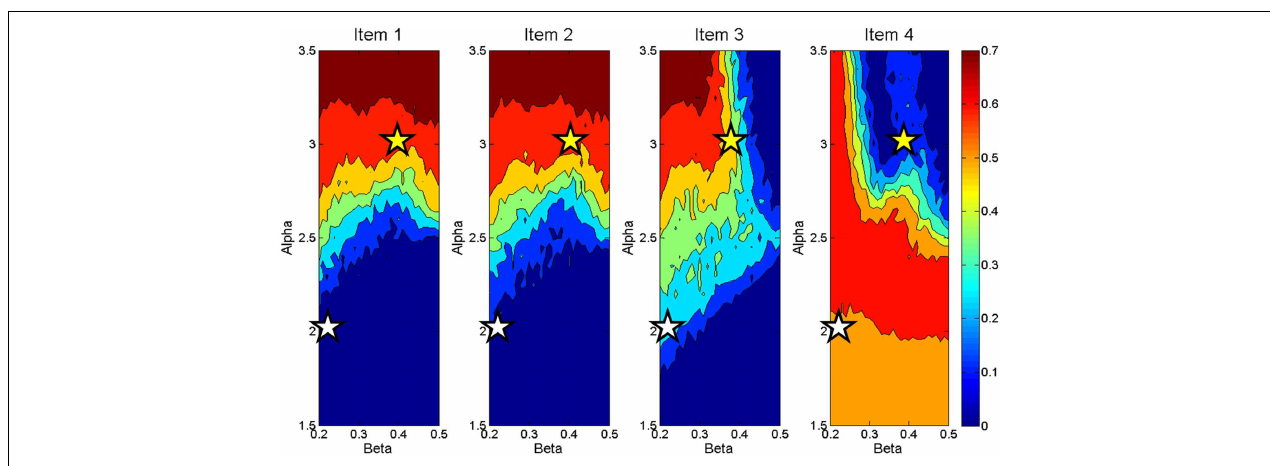
FIGURE 3 | Contour plot displaying activation values of four items at end of data presentation across a range of Beta ( X axes) andAlpha ( Y axes) demonstrating differences in activation weight gradients produced by the working memory